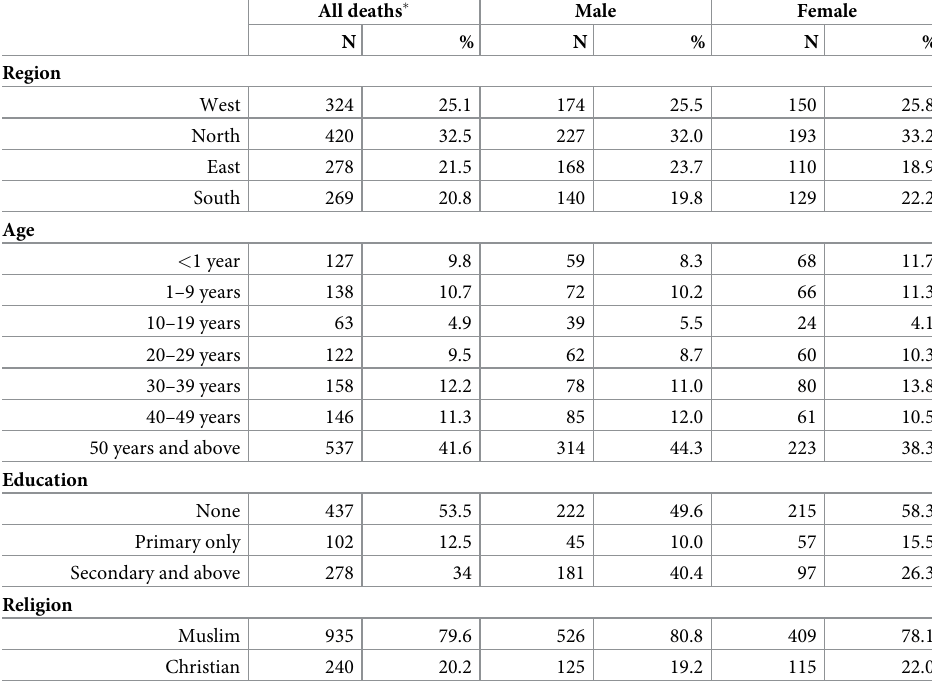
Table 2. Descriptions of the deaths reported in the sample, Sierra Leone, April 2017. All deaths